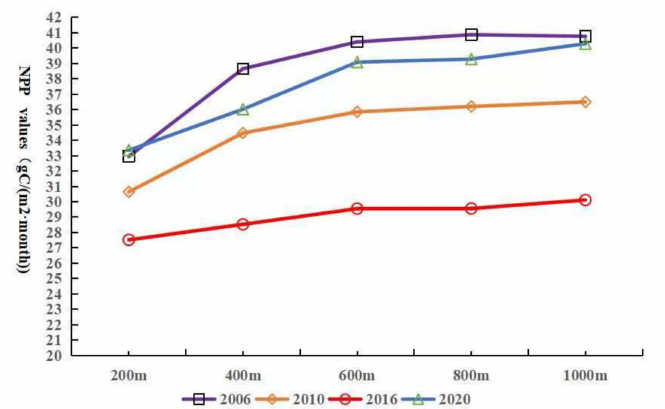
Figure 7. Variation trend of buffer zone NPP